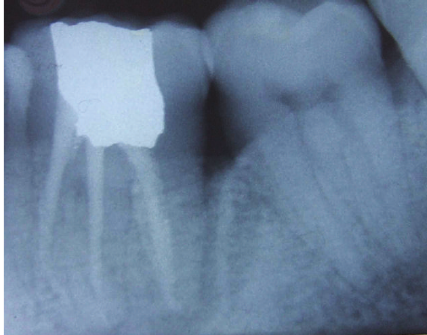
Figure 8: 3-year